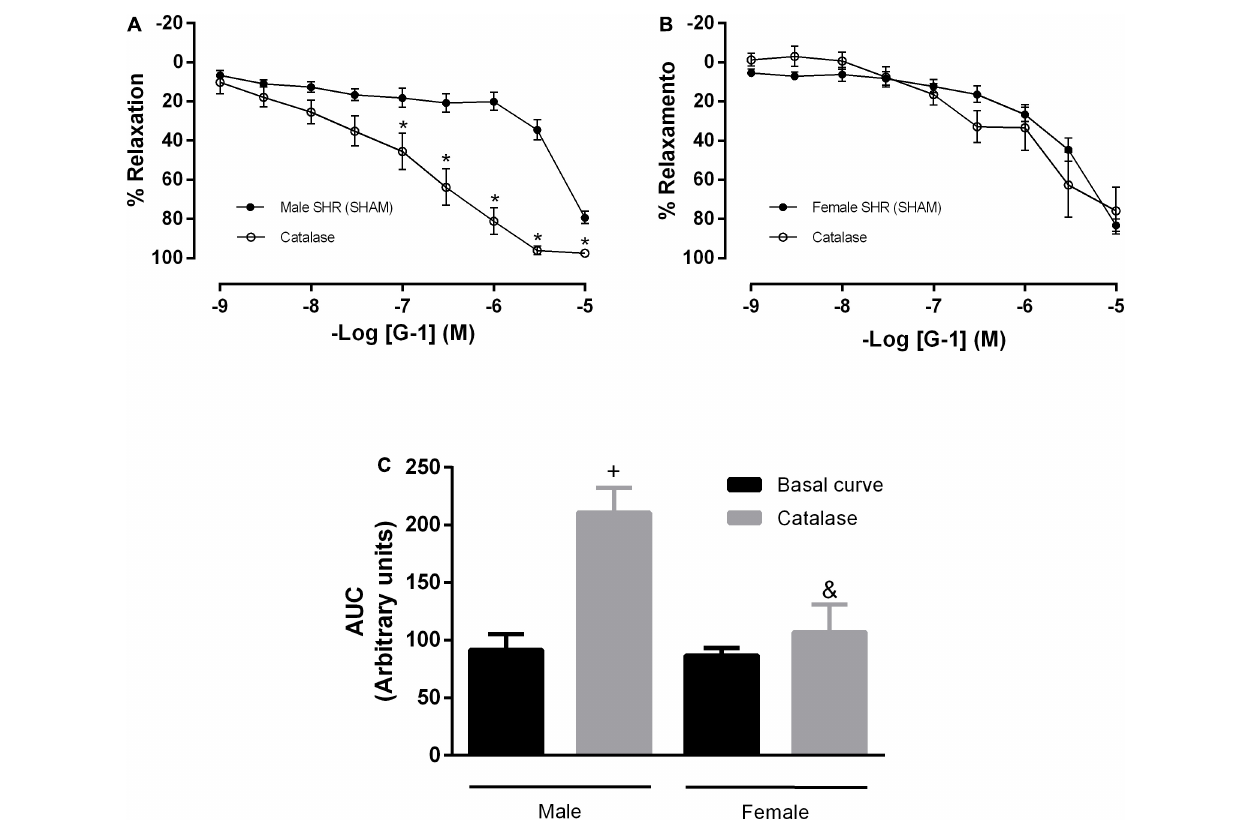
FIGURE 8 | Concentration-response curves of the selective GPER agonist G-1 (1 nM-10 µ M) in mesenteric resistance arteries from both sexes. Isolated effect of an enzyme that specifically de composes H 2 O 2 (Catalase, 1,000 units/mL) in (A) Male ( n = 7) and (B) Female ( n = 5) SHR groups. (C) Area under the curve (AUC) before and after catalase incubation. Values are expressed as the mean ± SEM. * P < 0.05 compared to the same dose in the control curve, + P < 0.05 compared to the AUC of the Male SHR control curve and & P < 0.05 compared to the AUC after catalase incubation of Male SHR group. The curve analysis was carried out point-by-point through two-way ANOVA, followed by the Sidak post hoc test. AUCs were evaluated through one-way ANOVA followed by Tukey post hoc